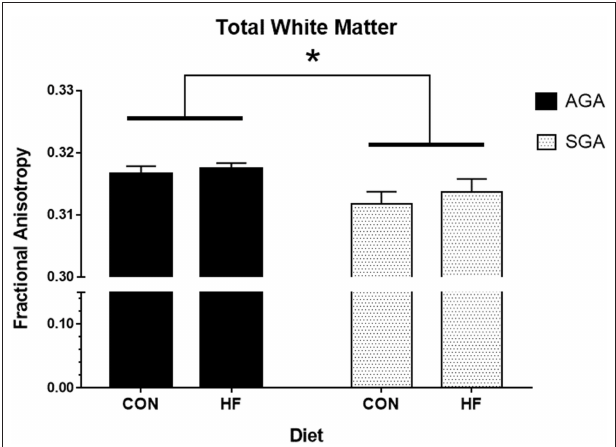
FIGURE 4 | Total white matter fractional anisotropy in AGA and SGA piglets fed HF or CON formula. Fractional anisotropy, a measure of white matter microstructural integrity, was decreased in SGA piglets * p = 0.022. AGA, appropriate for gestational age; SGA, small for gestational age; CON, control; HF, hydrolyzed fat. Data are presented as mean ± SEM, AGA n = 5 per group, SGA n = 6 per